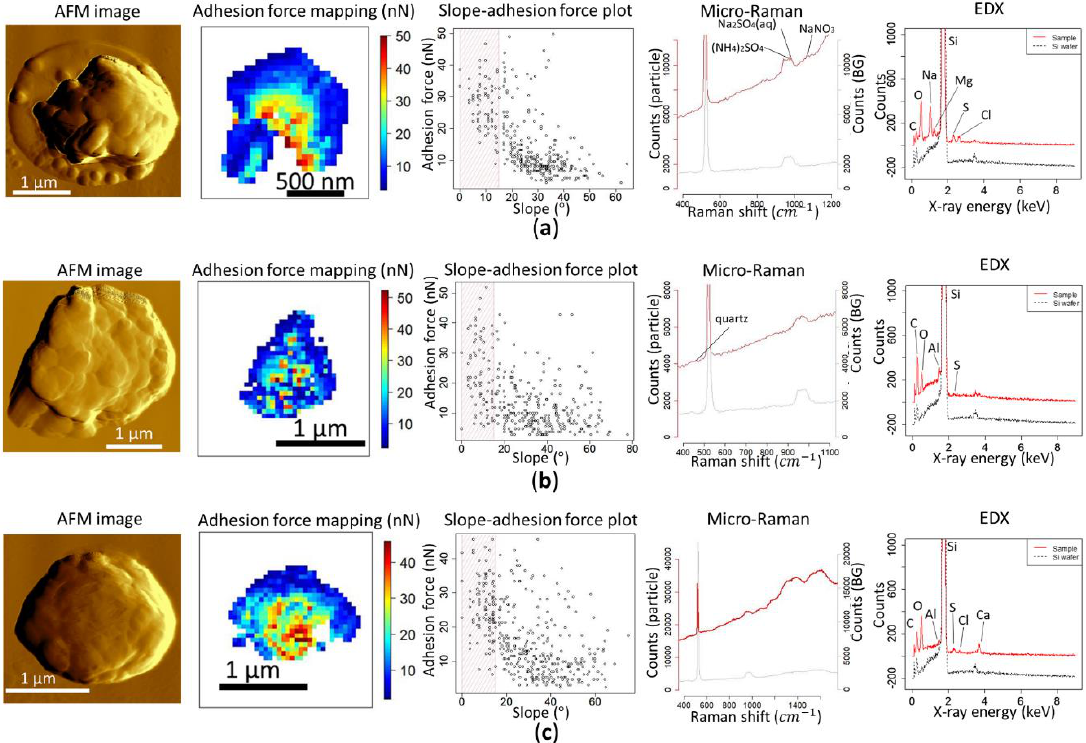
Figure 5. Atomic force microscopy (AFM) images, adhesion force mapping images, slope – adhesion force plots, micro-Raman, and EDX spectra results of ambient aerosol particles identified as ( a ) sea salt, ( b ) silicate dust, and ( c ) Ca-rich dust. Corresponding AFM height and phase images can be found in Figure S5 in the Supplementary Information.